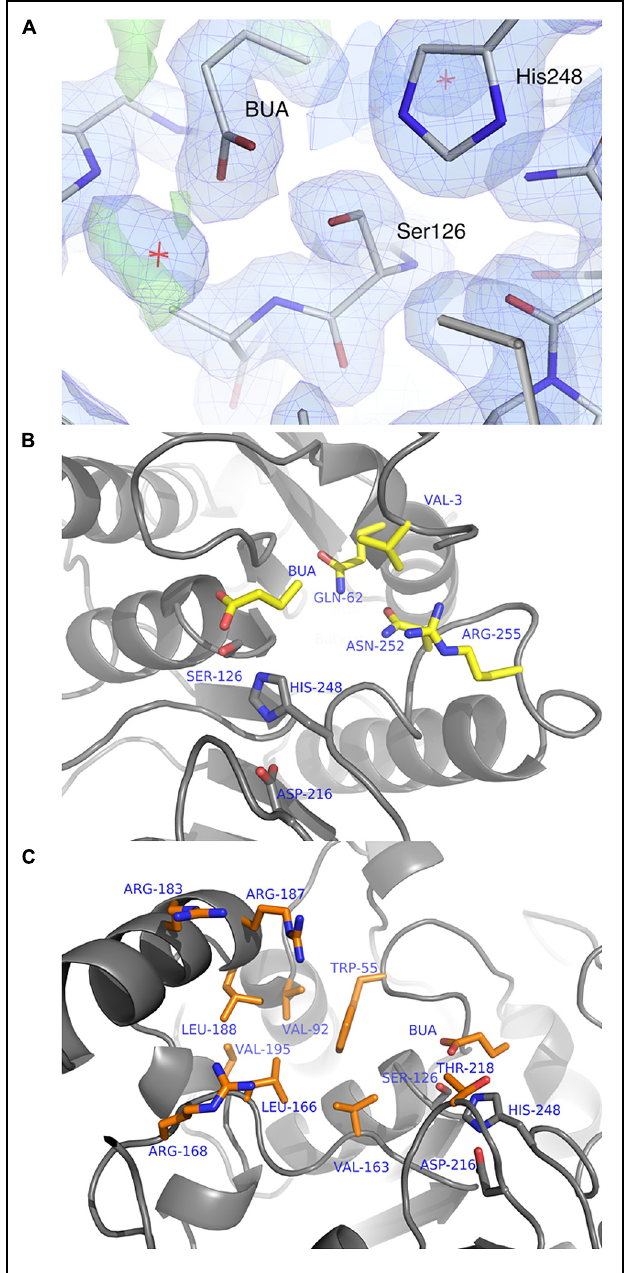
FIGURE 4 | (A) The electron density maps showing the butyrate ligand (BUA) bound in the TtEst2 active site. The 2F o − F c (blue) is contoured at 1.2 σ and the F o − F c map is contoured at 3.5 σ (green) and -3.2 σ (red). The ligand and amino acid residues are shown as stick models. The catalytic Ser126 and His248 are annotated. (B) Structural features of the TtEst2 carboxyl binding site responsible for the binding of the substrate acyl group. The protein backbone is shown as a cartoon, the butyrate molecule (BUA) and the side chains of the carboxyl pocket amino acid residues are shown as stick models with carbon atoms in yellow and active site triad residues are shown with carbon atoms in gray. (C) Structural features of the TtEst2 alcohol binding site. The butyrate ligand (BUA) and the side chains of the amino acid residues lining the active groove are shown as stick models with carbons in orange, the active site catalytic residues in gray and the protein backbone is shown as a